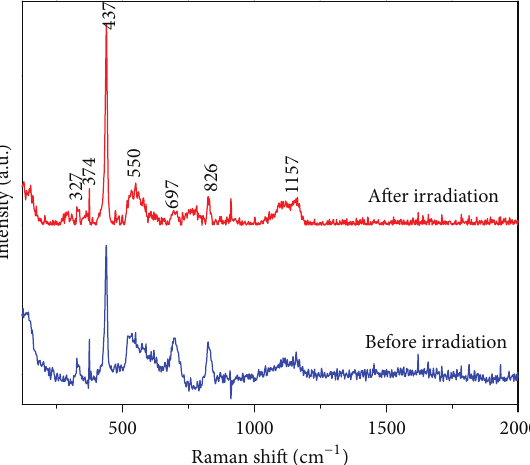
Figure 5: Raman spectroscopy of ZnO-based thin films.